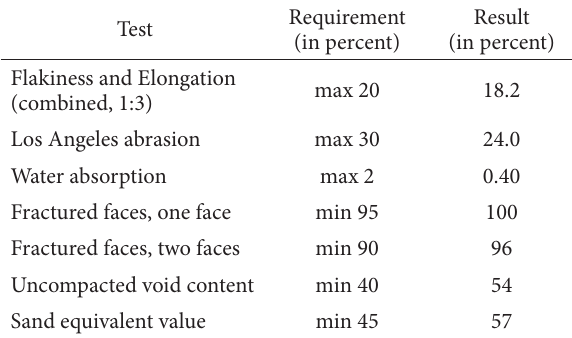
Table 1. Physical properties of aggregates ( ASTM D7064:2013 ) Requirement Test (in percent) Flakiness and Elongation (combined,